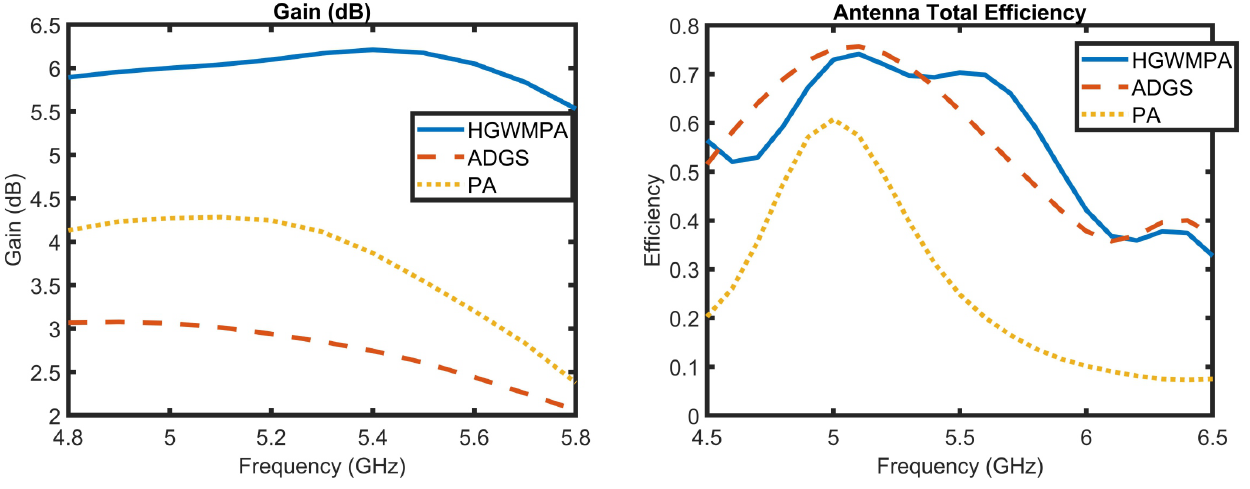
FIGURE 13. Total efficiency of the PA, ADGS and